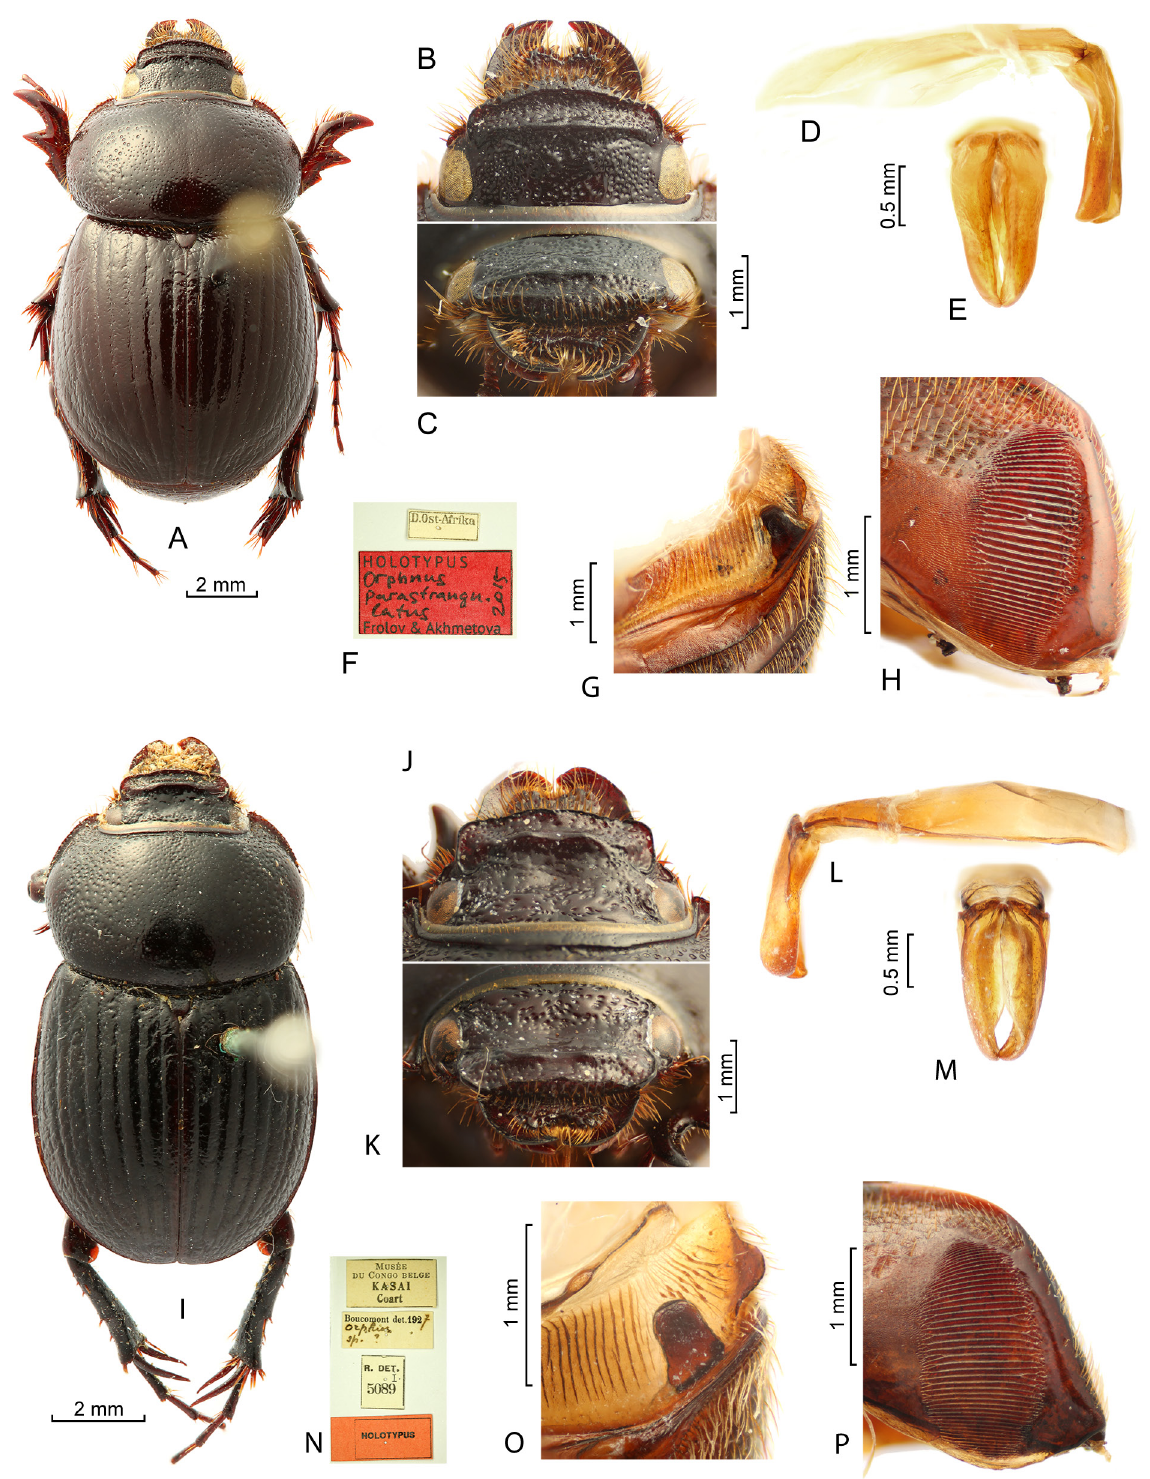
Fig. 5. — A–H . O. parastrangulatus sp. nov. A . Habitus. B–C . Head in dorsal and apical view. D . Aedeagus in lateral view. E . Parameres in dorsal view. F . Label of holotype. G . Abdomen in dorsal view. H . Stridulatory field. — I–P . O. strangulatus Paulian, 1948 . I . Habitus. J–K . Head in dorsal and apical view. L . Aedeagus in lateral view. M . Parameres in dorsal view. N . Label of holotype. O . Abdomen in dorsal view. P . Stridulatory field. A–H, I, N.